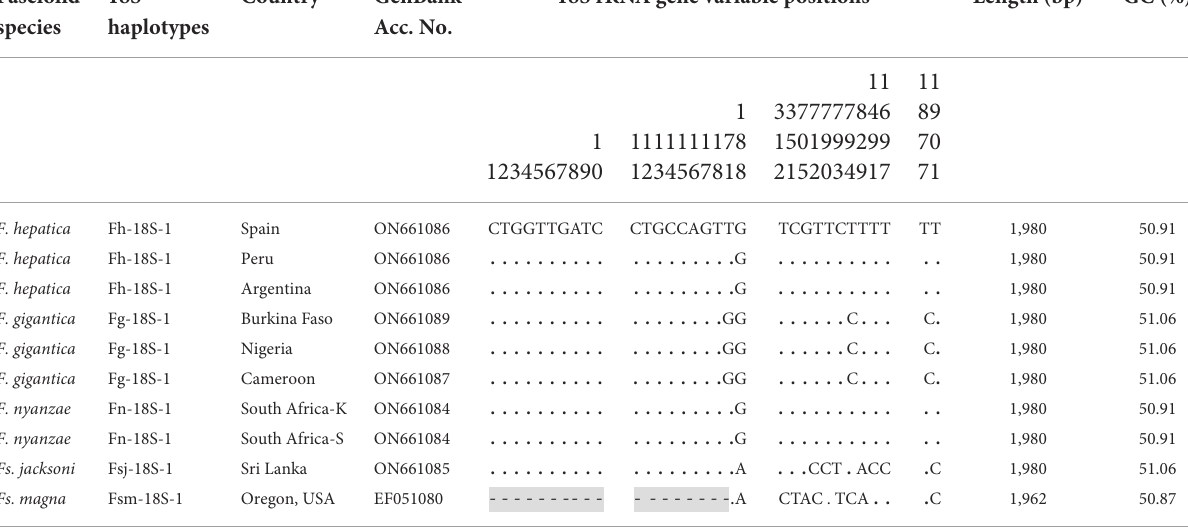
TABLE 1 Polymorphic sites in the sequence comparison of the complete 18S rRNA gene sequence of Fasciola hepatica, F. gigantica and F. nyanzae together with Fascioloides jacksoni and Fs. magna . Fasciolid